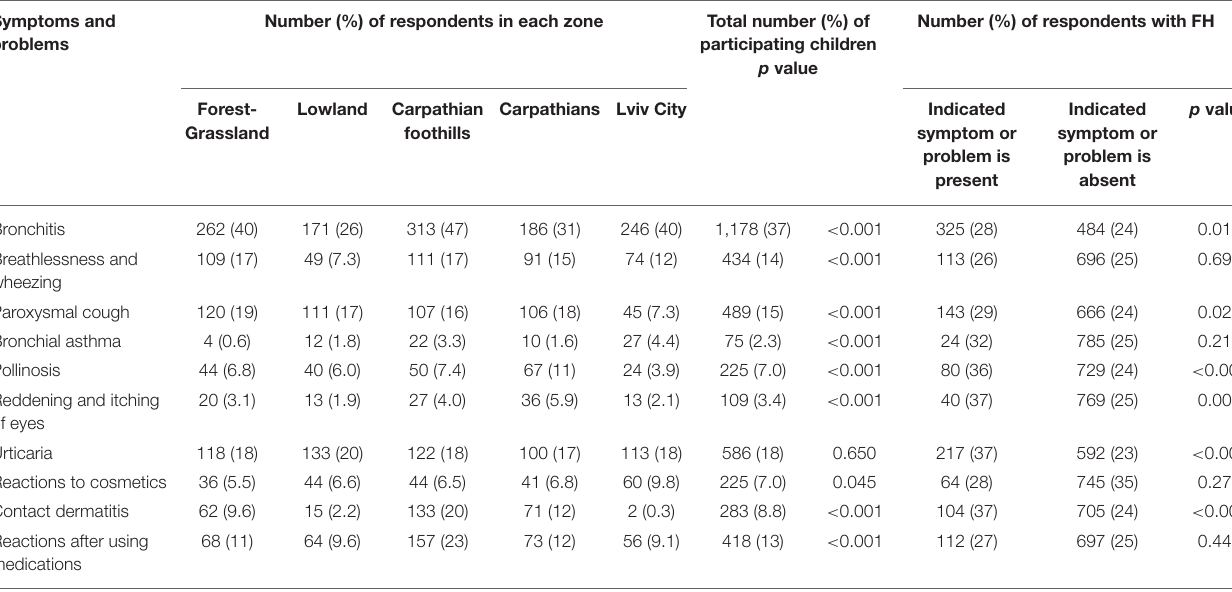
TABLE 5 | Distribution of children among geographic and climate zones and presence of physical symptoms and complications * . Symptoms and